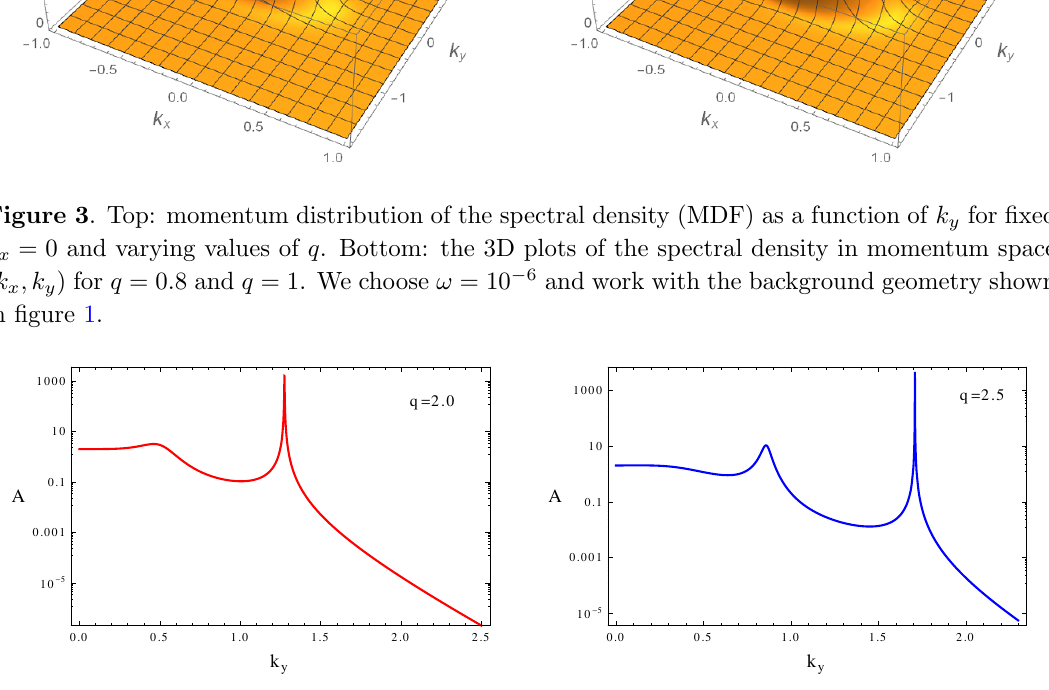
Figure 4 . MDF spectral density as a function of k y for q = 2 : 0 (left) and q = 2 : 5 (right). We have (cid:12)xed k x = 0 and ! = 10 (cid:0) 6 . In each plot there is a very sharp spectral weight indicative of a Fermi surface. Note that the vertical axis is logarithmic, causing the peak to have a spike-like